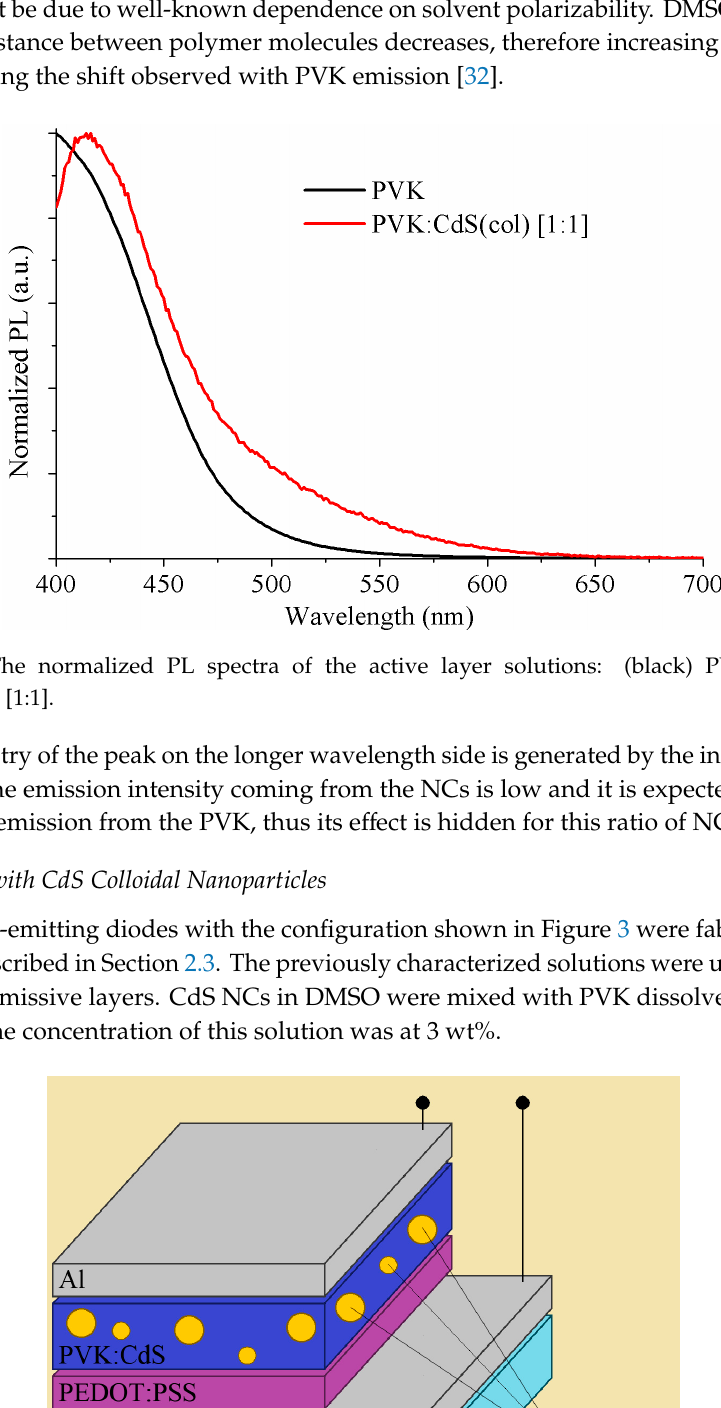
Figure 3. Schematic structure of hybrid LED with PVK:CdS active layer.